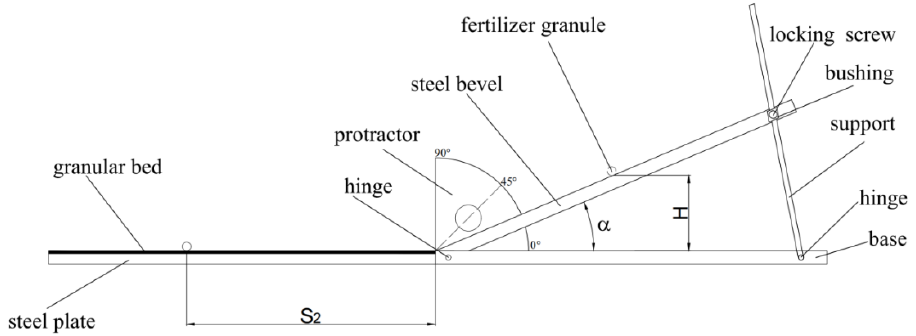
Figure 6. Schematic diagram of measuring device for rolling friction coefficient of fertilizer-fertilizer.